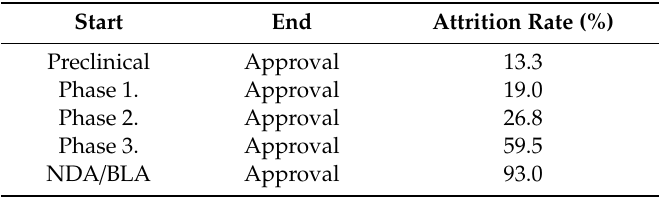
Table 2. POS in each development